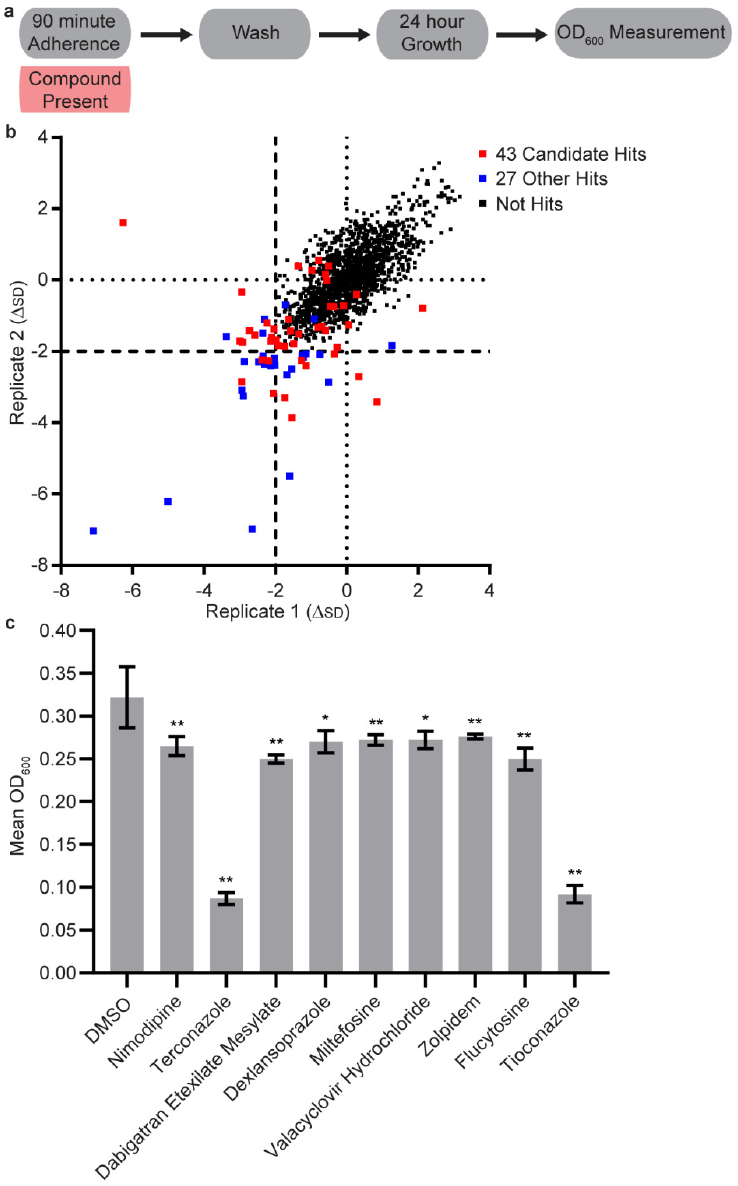
Figure 1. High-throughput screening of the Pharmakon 1600 compound library for the ability to inhibit C. albicans biofilm formation. ( a ) Overview of the adherence inhibition optical density biofilm assay used in these experiments. Compounds were included at a concentration of 10 µM during the 90-min adherence step but not in the 24-h growth step of in vitro biofilm formation. ( b ) Comparisons of the differences from the mean, in units of standard deviation, for each of the 1600 compounds in the two replicate assays. The 43 candidate hits that were pursued further are indicated in red. The 27 other hits that were not pursued, which consisted of a mixture of well-known antifungal agents, compounds intended for topical use, and compounds with high toxicity values (<100 mg/kg), are indicated in blue. All other compounds are indicated in black. On each axis, the dotted lines indicate